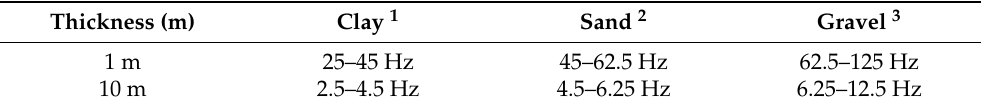
Table 1. Estimated fundamental frequencies using Equation (1) for different beach thickness and Vs